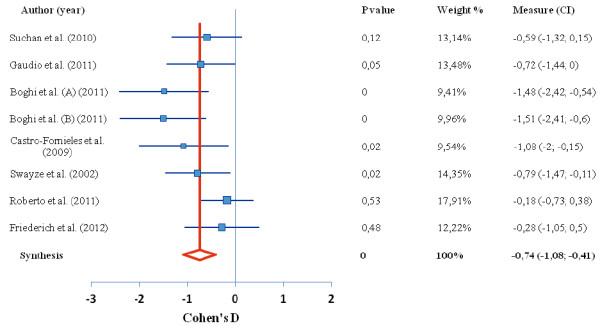
Difference in WM volume between anorexia nervosa and control group. Forest plot depicting the difference in global white matter volume between patients with AN and healthy controls. Authors of study are given on left, red line indicates median, blue boxes indicate separate studies; p value = statistical significance threshold; weight % as adjusted for study population size; CI = confidence intervals.